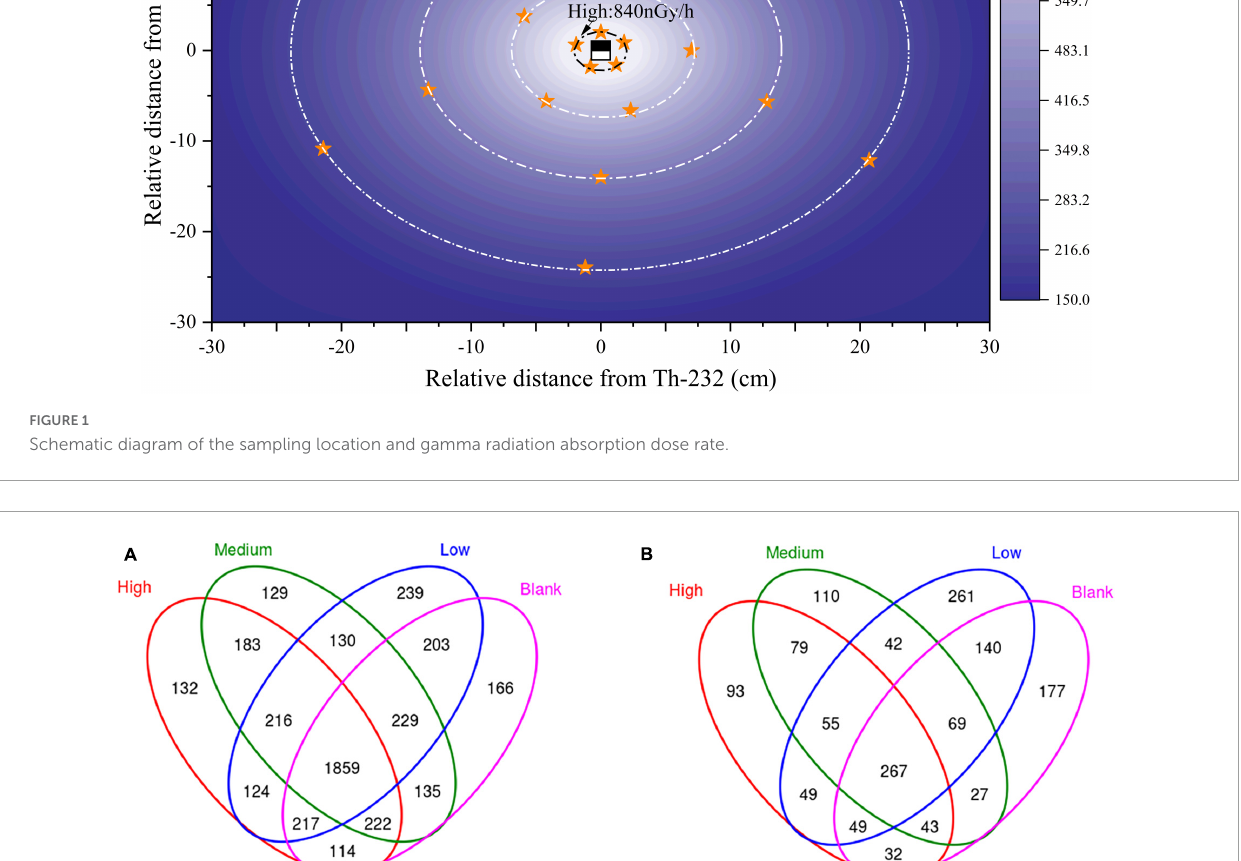
FIGURE2 Venn diagram of panel (A) 16 S and (B) ITS OTUs under different radiation intensities.